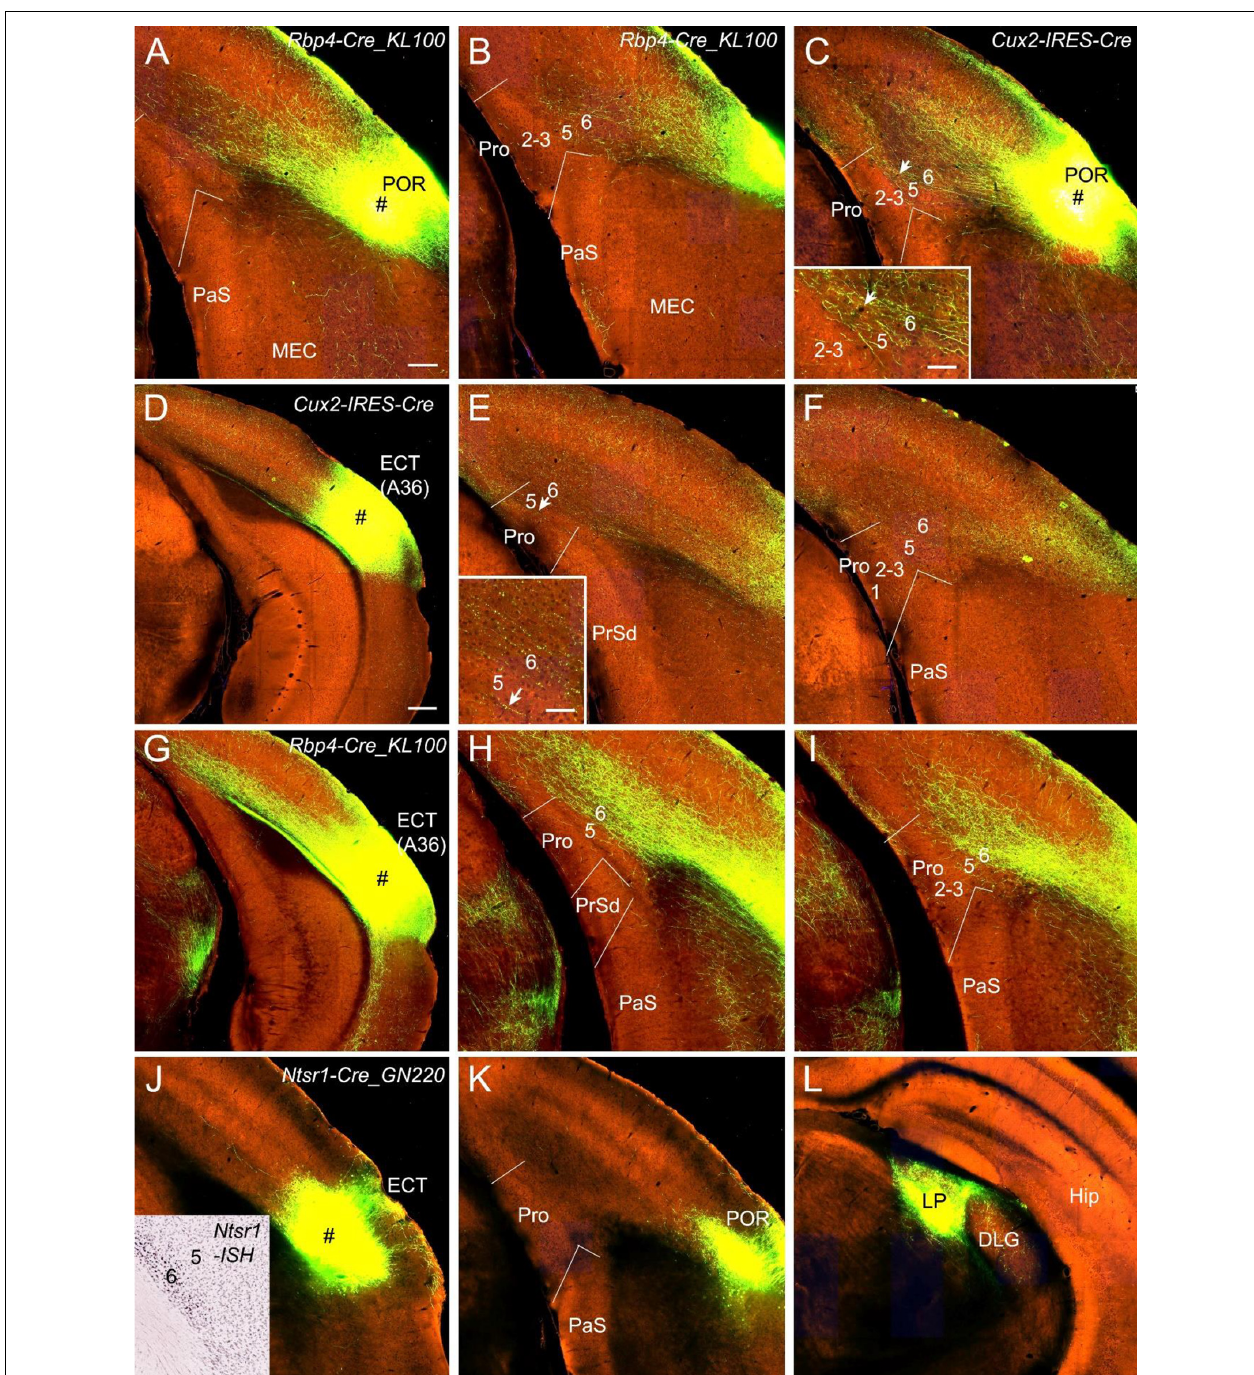
FIGURE 5 | Projections from postrhinal and ectorhinal cortices to the Pro. (A,B) An injection in POR (# in A ) of a Rbp4 -Cre_KL100 mouse (Cre expression in L5) produces moderate and weak terminal labeling in L6 and L5 of the Pro, respectively (A,B) . (C) An injection in POR (#) of a Cux2 -IRES-Cre mouse (Cre in L2–4) leads to moderate terminal labeling in L6 (with less in L5) of the Pro, which is magnified in the inset. ( D–F ) An injection in ECT (i.e., Brodmann area 36; # in D ) of a Cux2 -IRES-Cre mouse (Cre in L2–4) results in weak terminal labeling in L6 of the Pro (E,F) . The labeling in L6 of the Pro is magnified in the inset. ( G–I ) An injection in ECT (# in G ) of a Rbp4 -Cre_KL100 mouse (Cre in L5) leads to strong terminal labeling in L6 of the Pro (H,I) . (J–L) An injection in ECT (# in J ) of a Ntsr1- Cre_GN220 mouse (Cre in L6; see the inset in J for ISH) produces no labeling in the Pro (K) and strong labeling in lateroposterior nucleus (LP in L ). Arrows in low- and high-magnification images of the Pro point to corresponding locations. Bars: 200 µ m in (A) (for A–C , E, F, H, I, J–L , and the inset in J ); 350 µ m in (D) (for D,G ); 70 µ m in the insets in (C) and (E) .